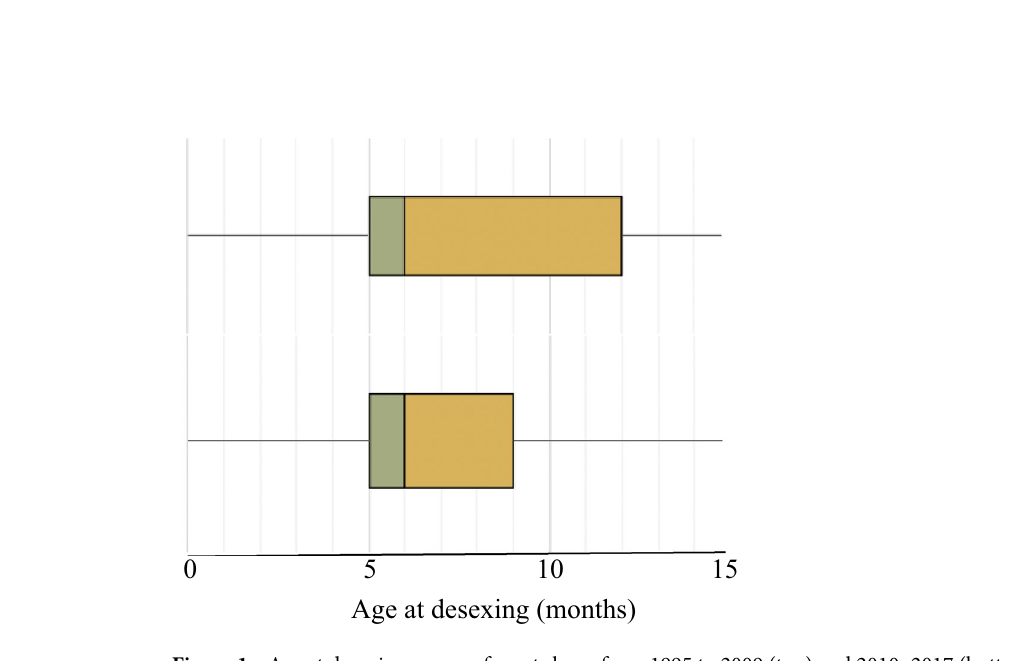
Figure 1. Age at desexing surgery for cats born from 1995 to 2009 (top) and 2010–2017 (bottom). Median and interquartile ranges are